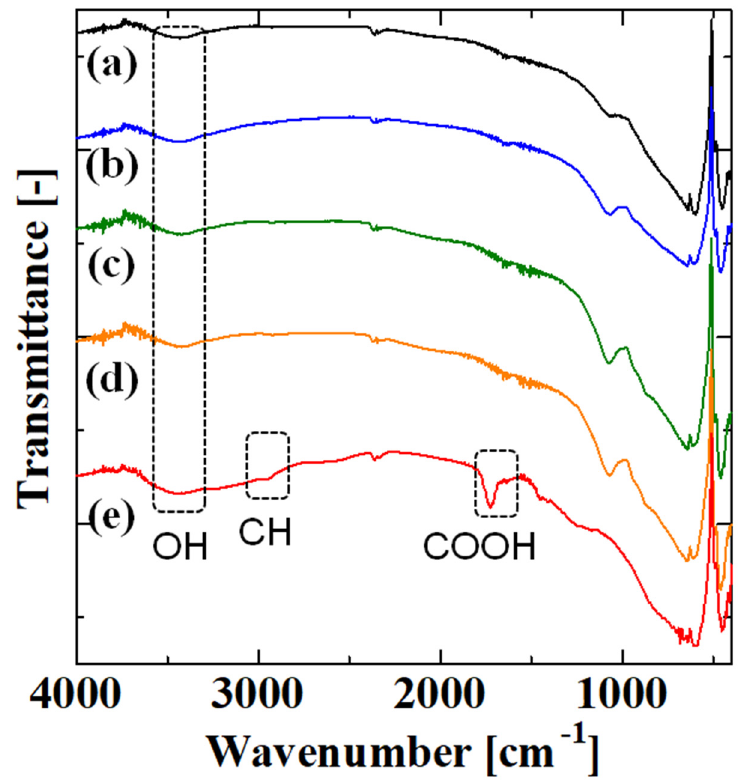
Figure 4. FT–IR spectra of the ( a ) uncoated alumina support and membranes obtained after the ( b ) first, ( c ) second, ( d ) third, and ( e ) fourth steps with four polymerizations.